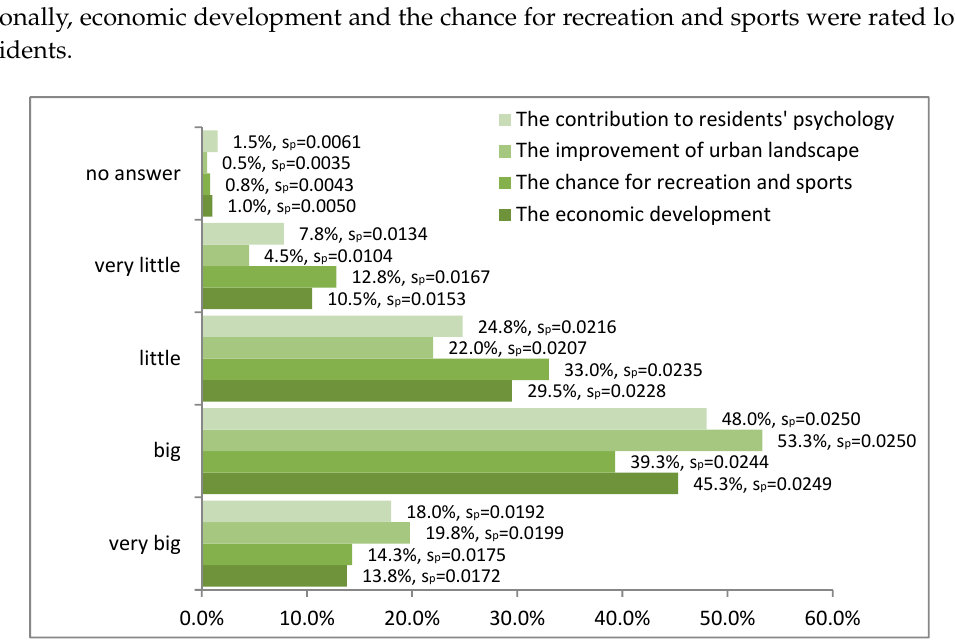
Figure 2. Contribution of pedestrian streets to residents’ quality of life.